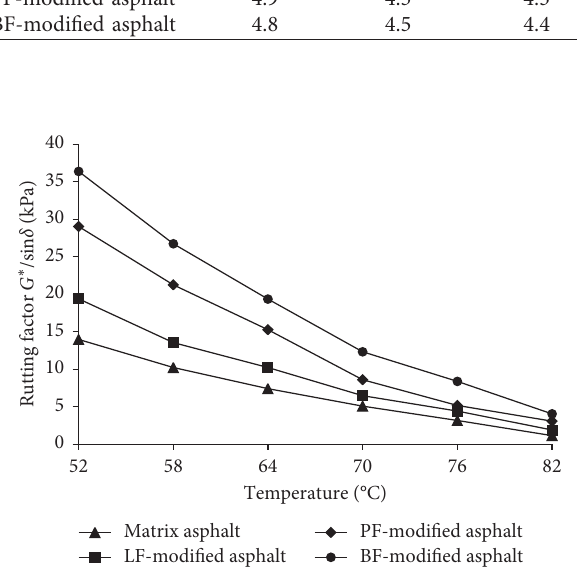
Figure 2: DSR results of the asphalt binder.